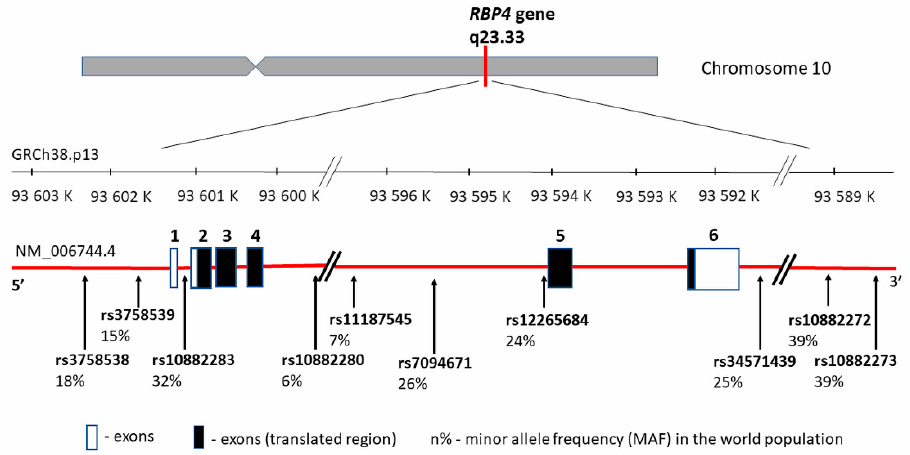
Figure 2. RBP4 gene structure, chromosome location, and cardiovascular disease (CVD) variants distribution. rs—number of the reference sequence in the National Center of Biotechnological Information database. Table 2. RBP4 gene variants investigated as risk factors of cardiovascular diseases in obesity.